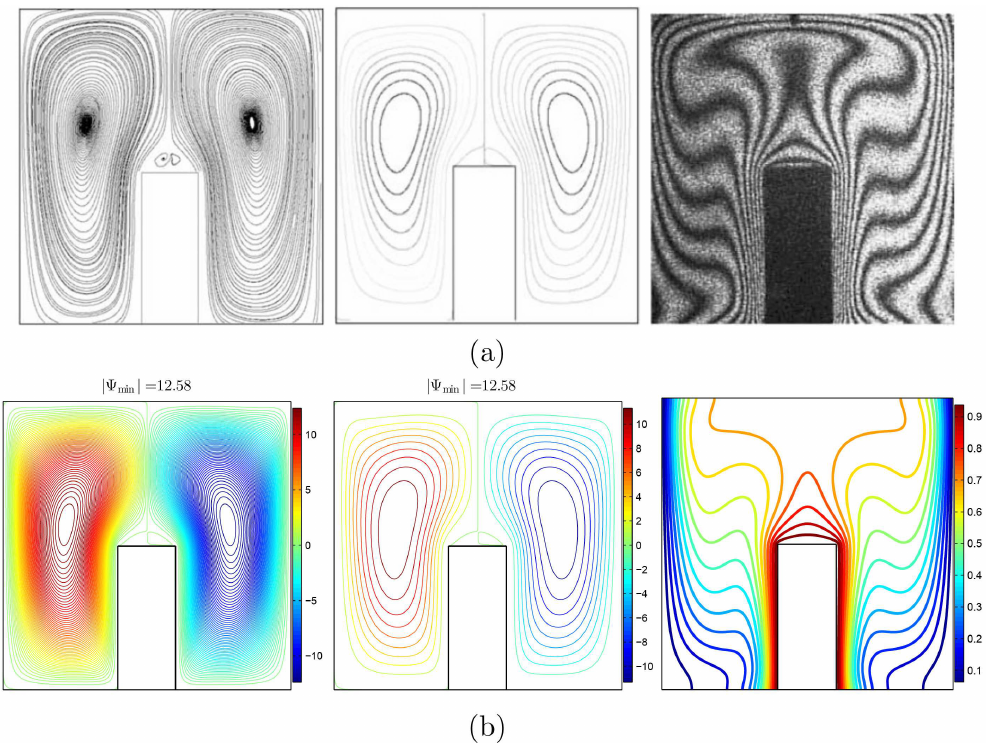
Figure 4. Paroncini and Corvaro [48] ( a ) and existing numerical outcome ( b ); experimental streamlines ( left ), numerical streamlines ( middle ), and experimental isotherms ( right ) at Ra = 1.78 × 10 5 , φ = 0, D = 0.5, A = 0, and Pr = 0.71.